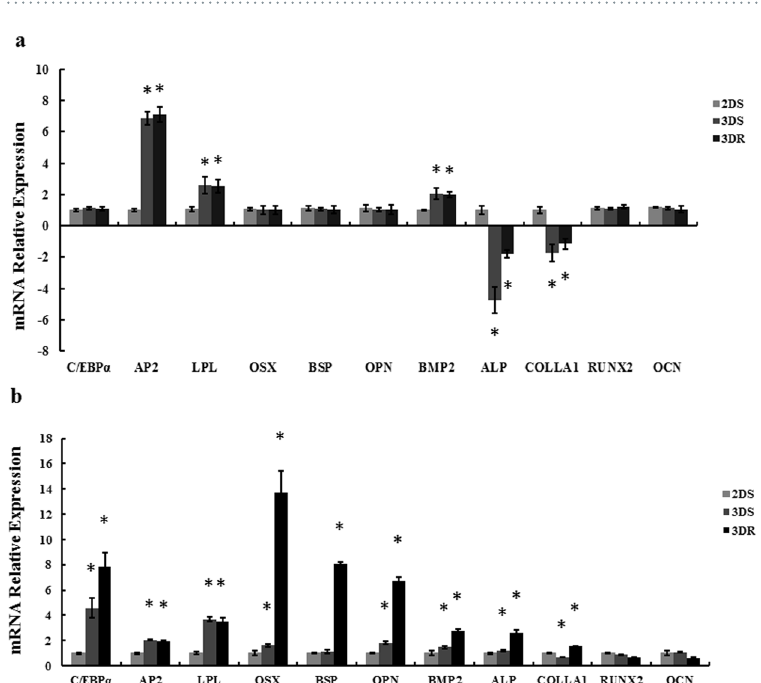
Figure 10. Adipogenic and osteogenic differentiation of BMSCs in static-2D, static-3D and RCCS-3D groups. ( a ) Q-PCR analysis of adipogenic gene expression levels and osteogenic gene expression levels before BMSCs in each group transplanted to 2D plates for 21 days adipogenic and osteogenic differentiation (N = 3, * p < 0.05). ( b ) Q-PCR analysis of adipogenic gene expression levels and osteogenic gene expression levels after BMSCs transplanted to 2D plates for 21 days adipogenic and osteogenic differentiation of BMSCs in each group (N = 3, * p <